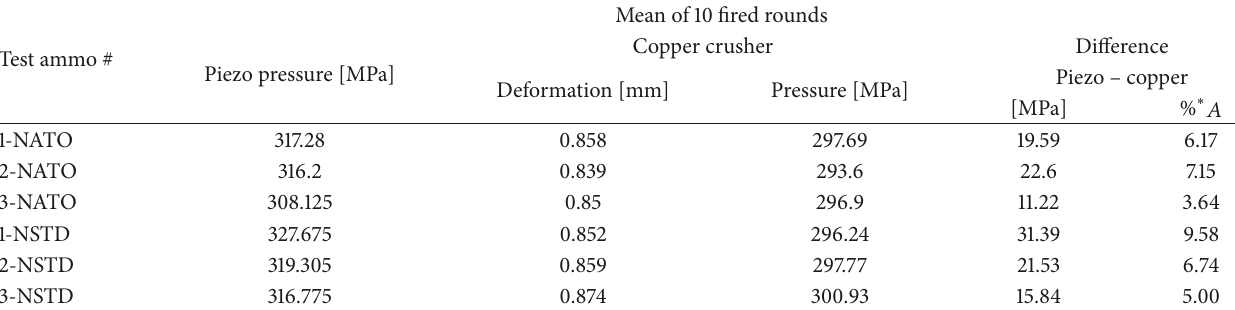
Table 3: Comparative analysis of piezoelectric transducer and copper pressure at 25 mm.